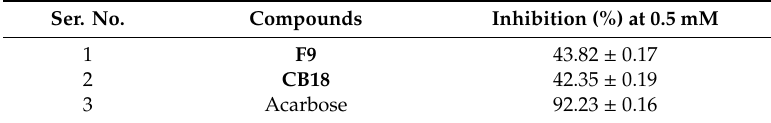
Table 5. GluE inhibition activity of isolates ( F9 & CB18 ) at 0.5 mM with Acarbose as standard. Each value represents average percentage inhibition ± standard error (S.E.) of three repeated experiments.